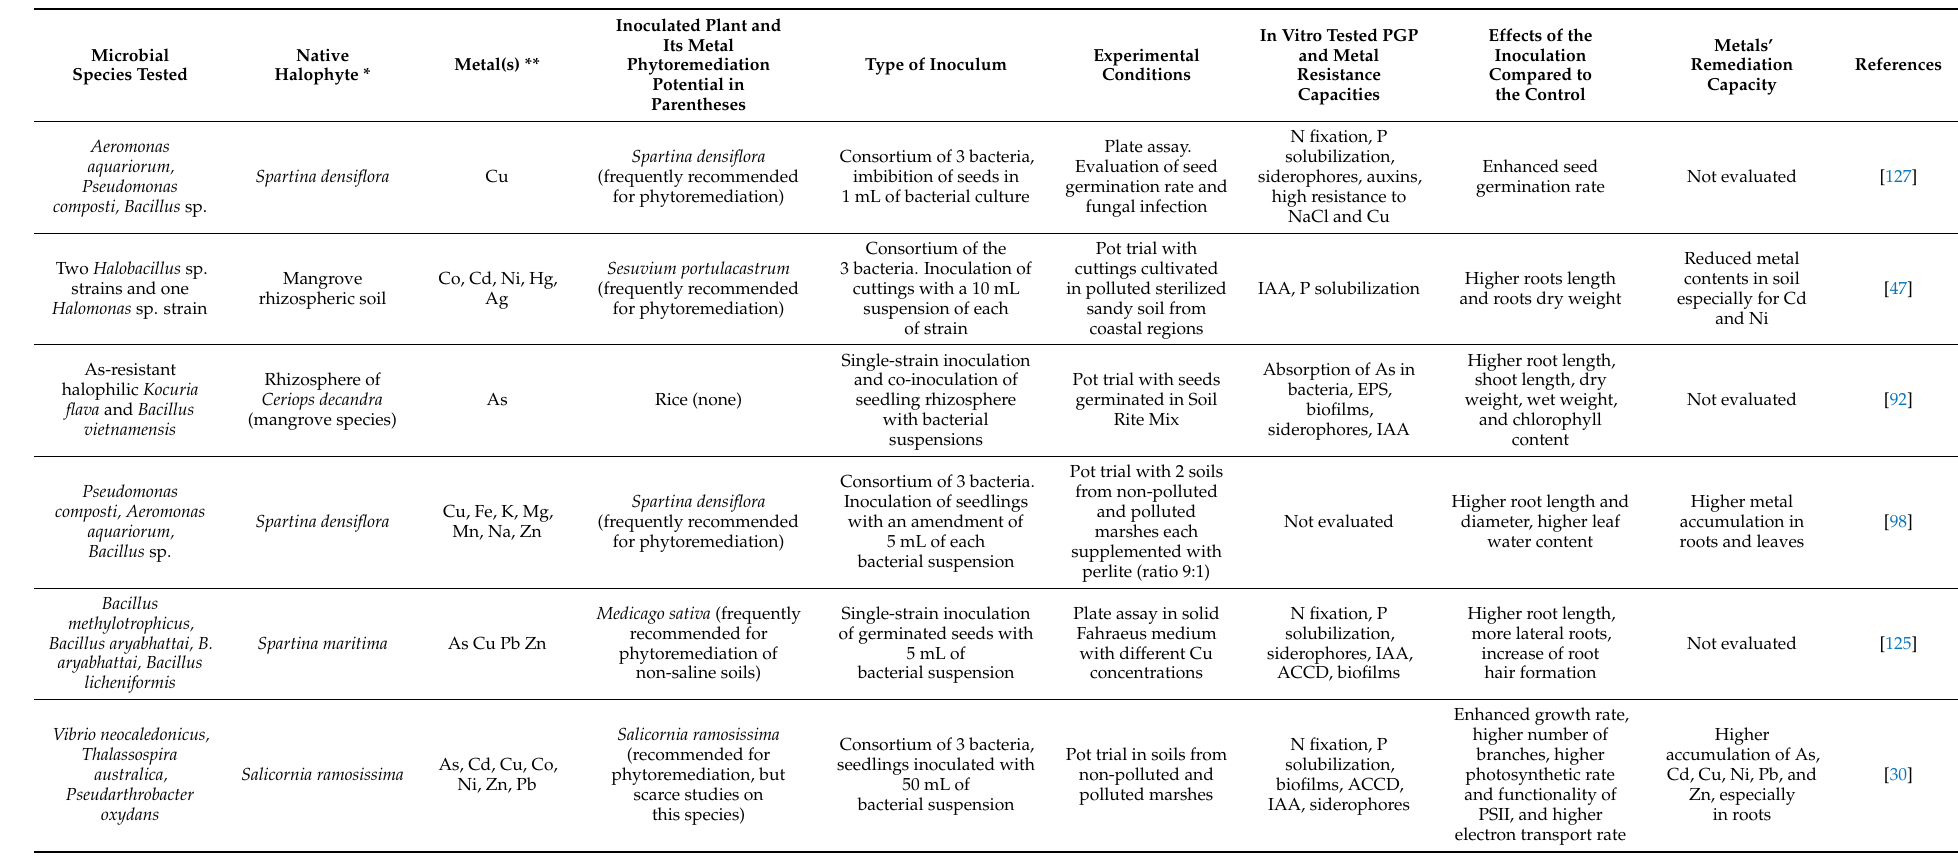
Table 1. Referenced studies that measured the effects of inoculation of halophytes-associated microbes on plants subjected to metal(s) and salinity